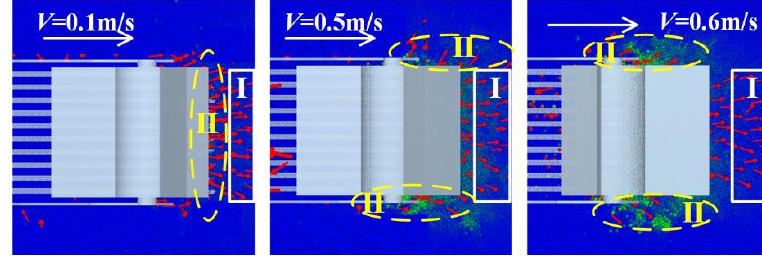
Figure 12. Vector image of red dates under different CWS.